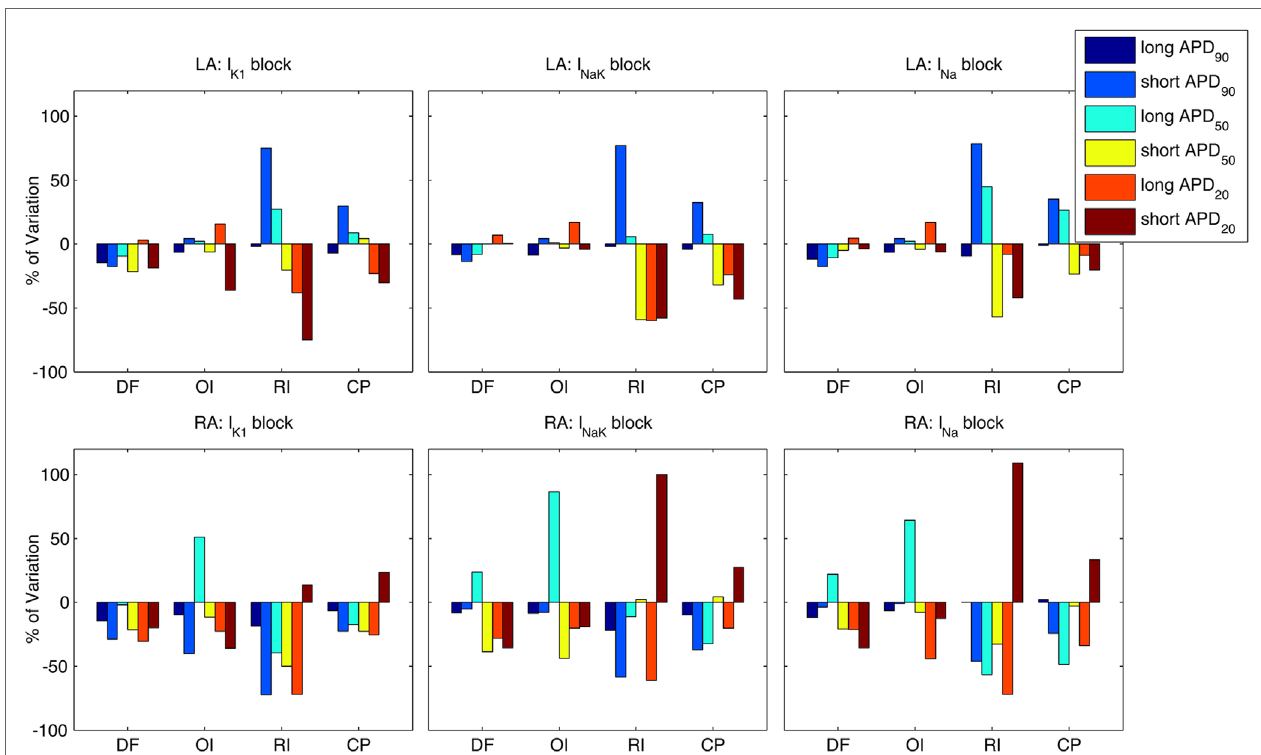
FigUre 8 | Modulation by action potential (aP) phenotype in intra-subject and intersubject variability in response to drug block . Percentages of variation of average indices of atrial fibrillation reentrant dynamics [dominant frequency (DF), organization index (OI), regularity index (RI), and coupling index (CP) x -axes] are presented for the six considered AP phenotypes. Top and bottom rows show results for left atrium (LA) and right atrium (RA), under partial block of I K1 (left column), I NaK (middle column), and I Na (right column),